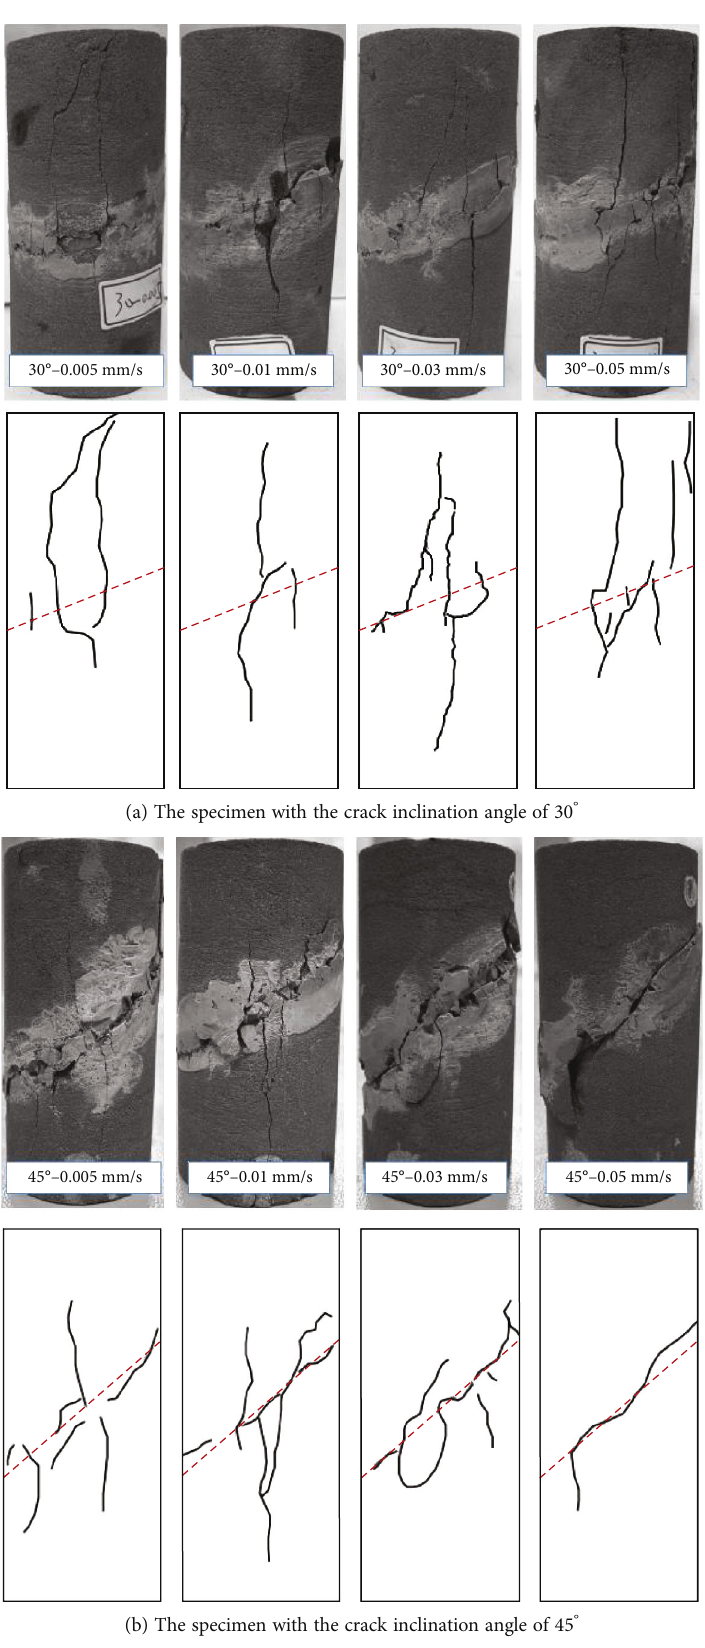
Figure 9: Macroscopic crack damage of the grouted body under di ff erent loading